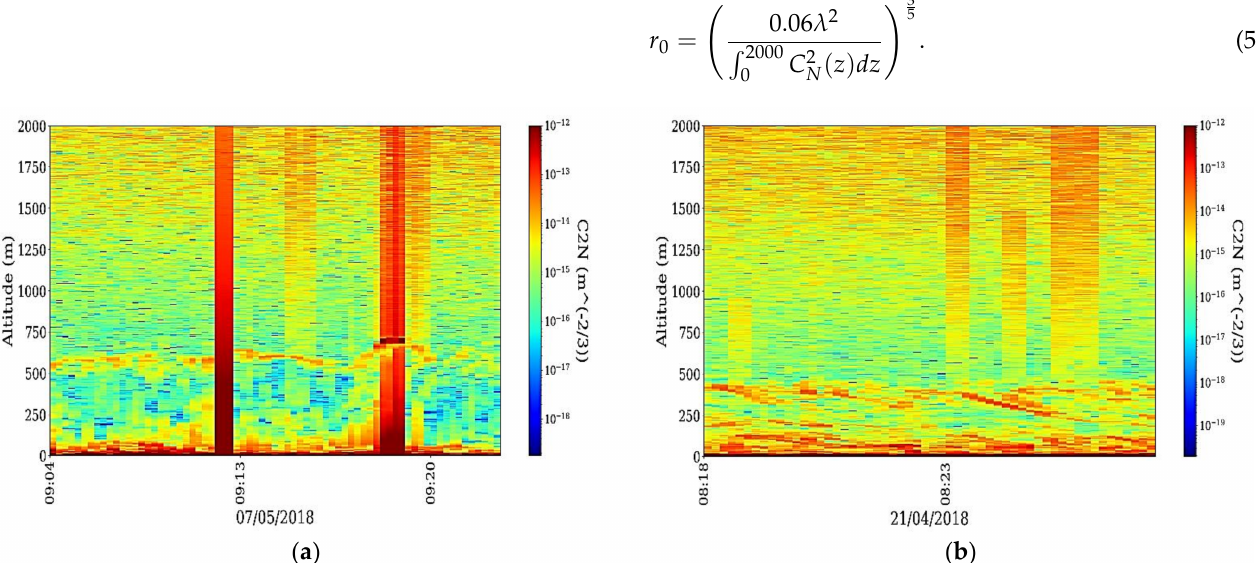
Figure 9. C 2 timeseries: ( a ) 07 May 2018, 15 s temporal resolution; ( b ) 21 April 2018, 10 s temporal N